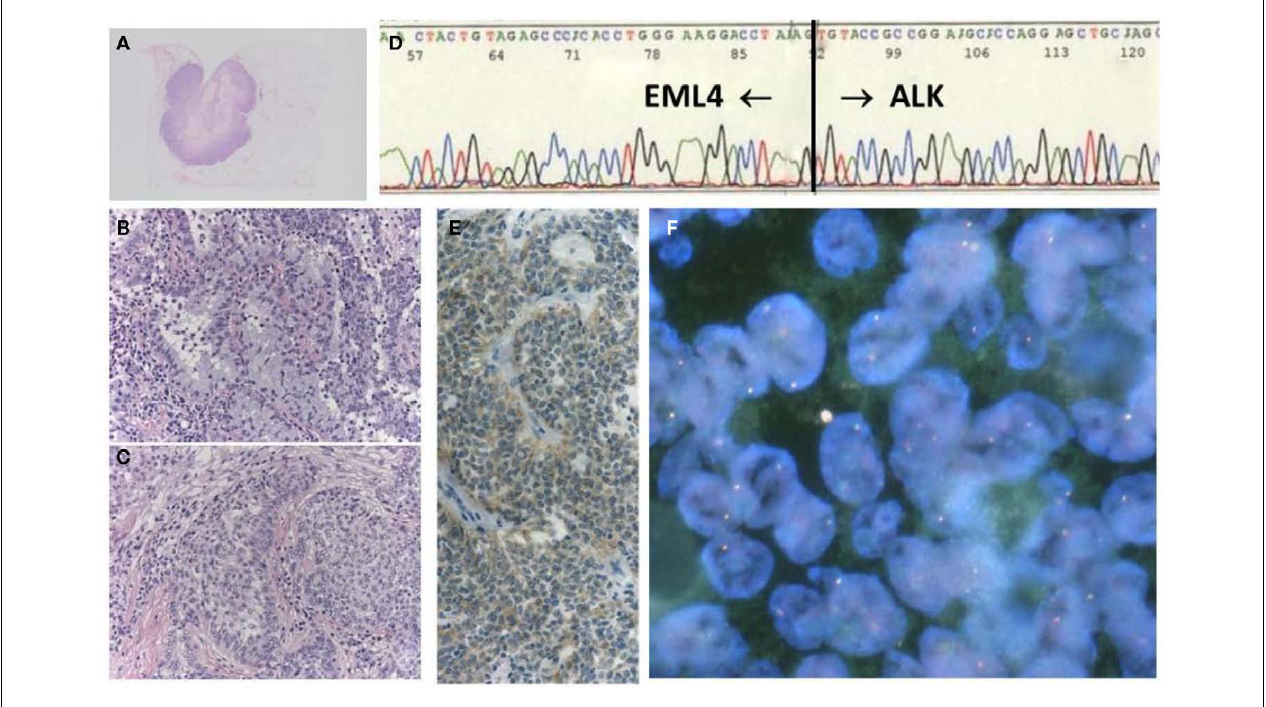
cell carcinoma (C) were histologically identified.The chimeric transcript was detected with RT-PCR products (D) , in addition to positive ALK-IHC (E) . However, FISH results did not fulfill the positive criteria (F)